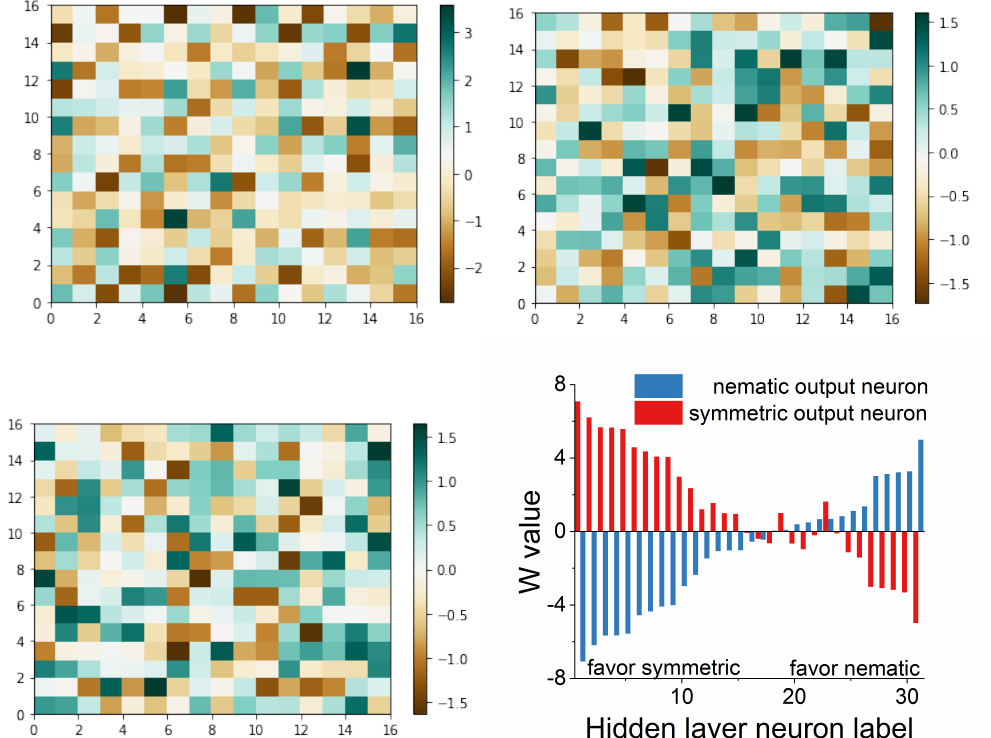
Figure 3: To analyze the criteria the ANN with a hidden layer detects the nematic order, we visualize the weights W between the 16 × 16 input neurons and the hid- den layer neuron (top left) with the largest contribution to the output neuron for the symmetric phase, and (top right) largest contribution to the output neuron for the nematic phase, as well as (bottom left) relatively neutral contributions to both the symmetric and nematic phases. It seems that identifying nematic order in these images depicting firing condition is as difficult a case as in the original STM images. (Bottom right) the distribution of the weights between the hidden layer neurons and the output neurons. The ANN outputs involve the collective contributions from mul- tiple neurons in the hidden